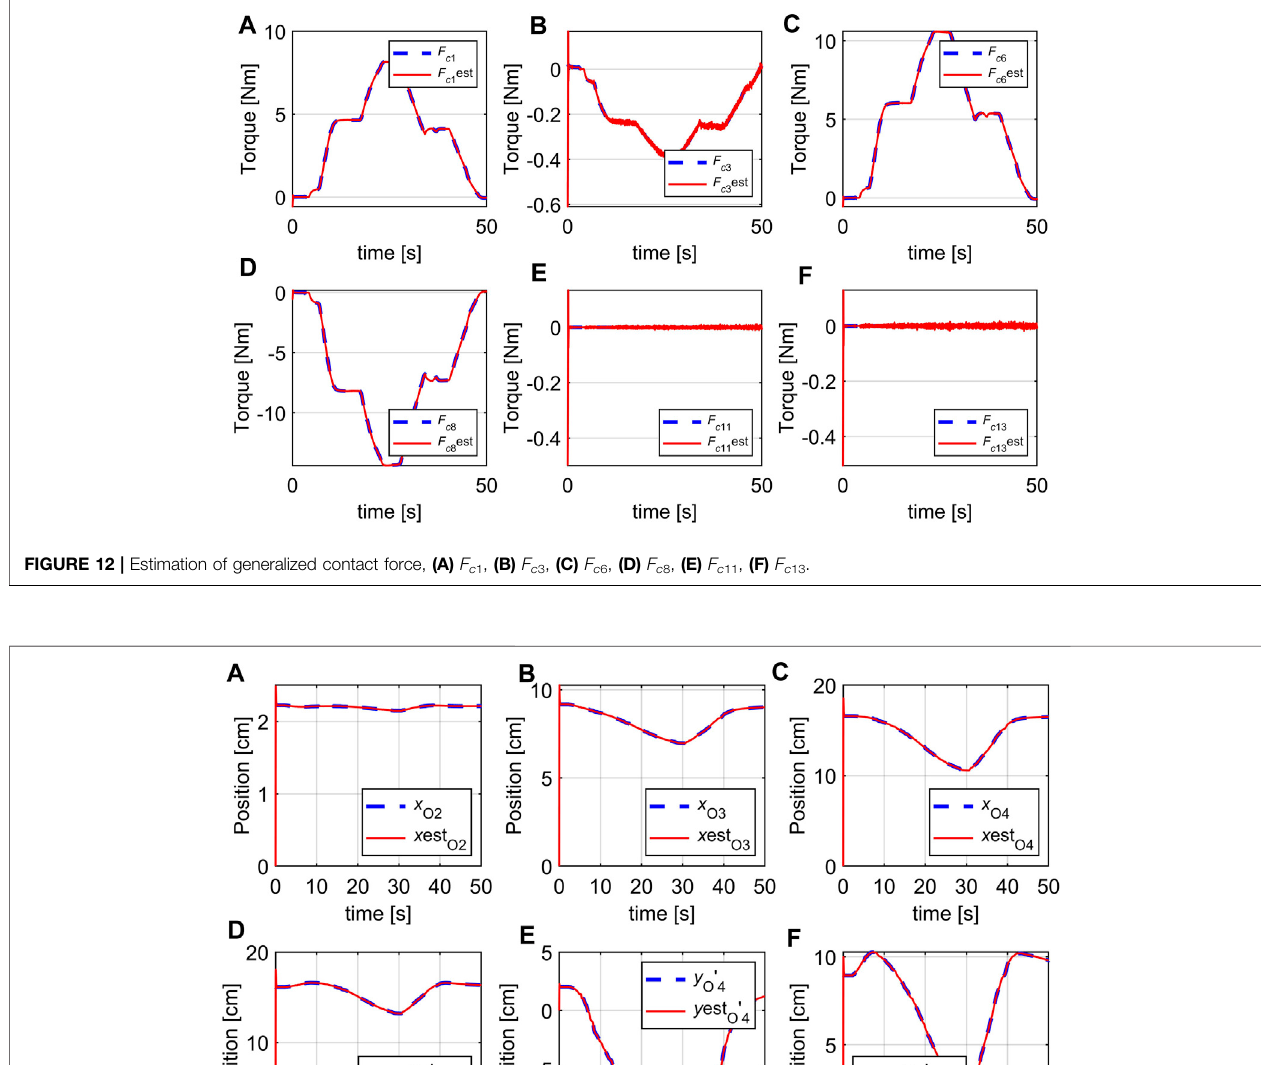
linearize the robot by a higher number of subsystems (at more pressure points) but the resulting system will be more complex. In this case, the biases happen in a short time with low magnitudes so their effects are negligible. Experiment 1: The result is shown in Figure 12 where the estimated generalized contact forces are red lines and the ground truth are blue lines. The initial values of estimated contact forces were set at − 0.5 Nm, while the initial values of the real generalized contact force were at 0 Nm (there is no contact at the initial time). It can be seen that the observer successfully estimates the generalized contact forces in this experiment with fast